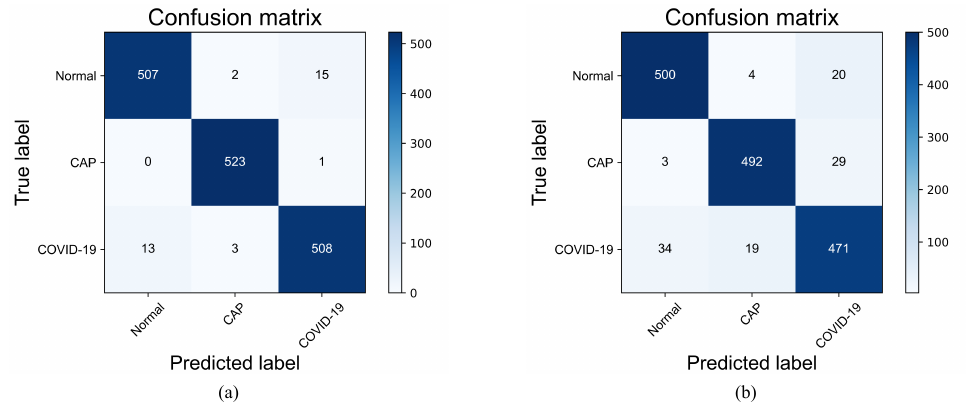
Figure 9. Confusion matrixes of two models tested on the integrated CT scan dataset. ( a ) represents the improved VGG19; ( b ) represents the original